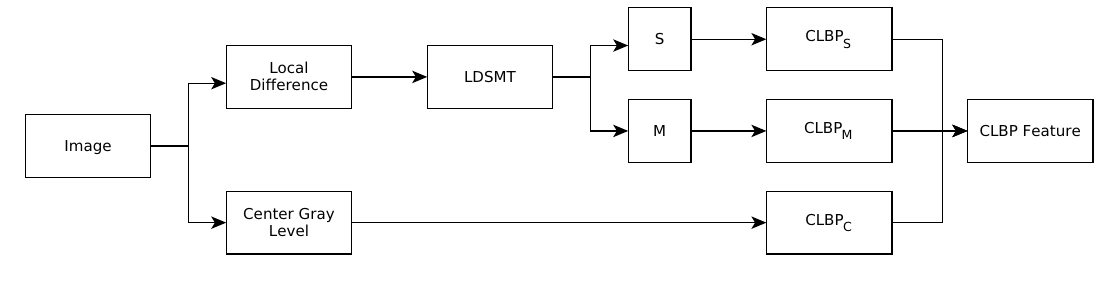
Figure 9. Framework of CLBP descriptor